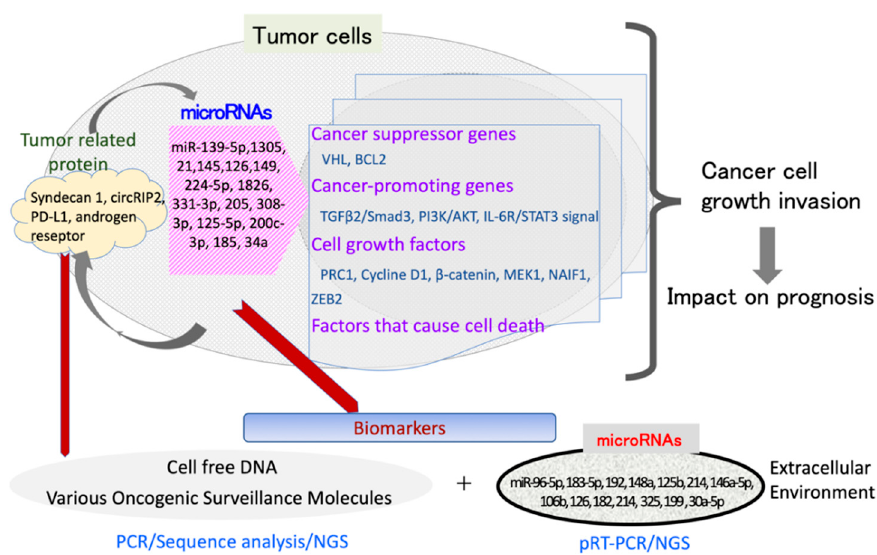
Figure 4. The function of cancer-related proteins and miRNAs in tumor cells and the detection of target genes by genetic analysis. Tumor-associated proteins and miRNAs control cell proliferation, invasion, and prognosis. Genetic analyses of DNA/RNA in tumor cells and cell-free DNA in body fluids are effective for diagnoses and prognoses. Table 1. miRNA for molecular biomarker.